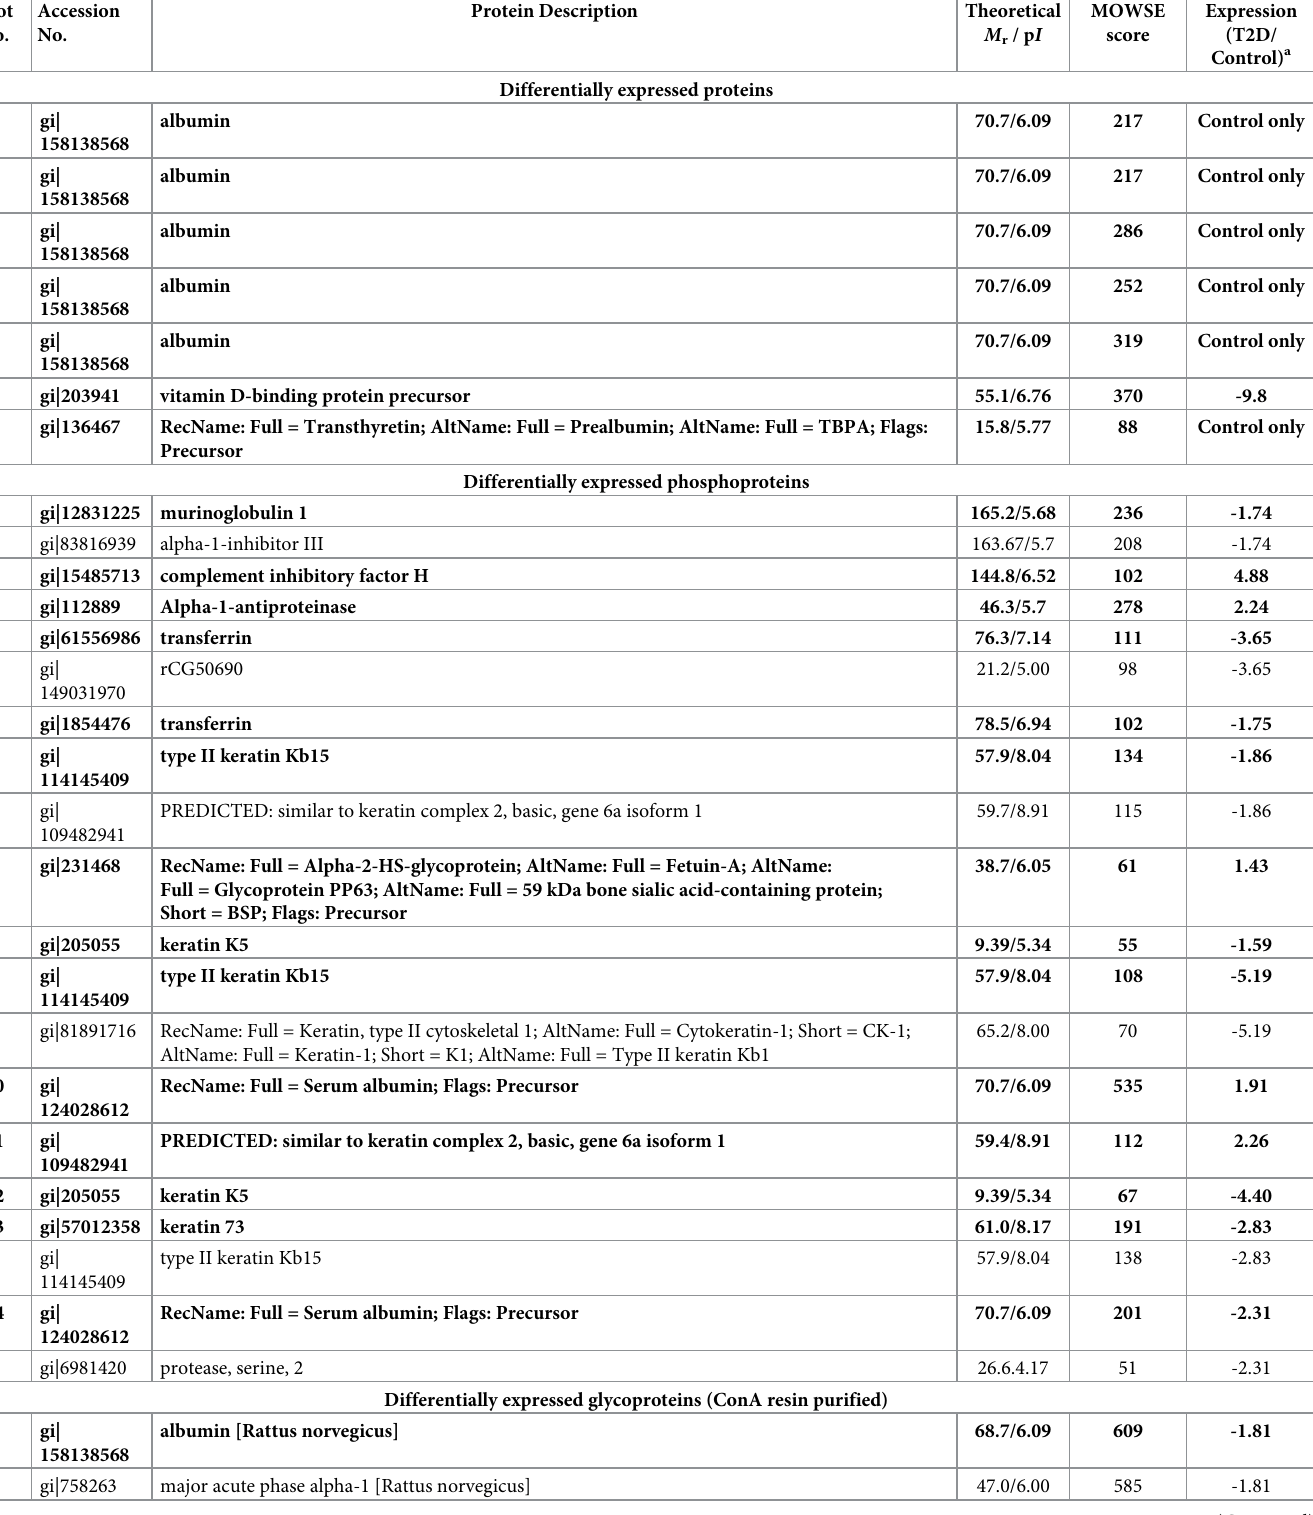
Table 2. MS/MS identification of the differentially expressed proteins, phosphoproteins, glycoproteins between the control and T2D serum pools. Spot